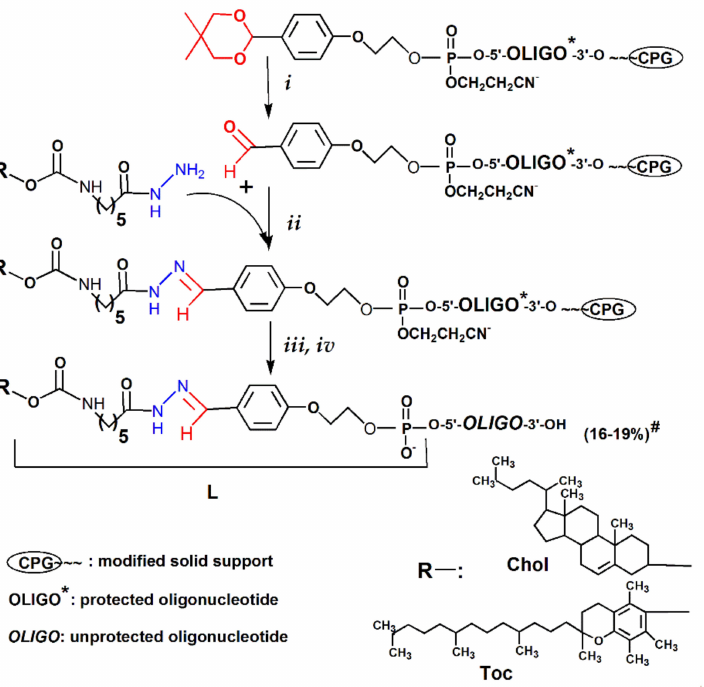
Figure 3. General scheme of the synthesis of 5 (cid:48) -lipophilic conjugates of oligonucleotides. Reagents: ( i ) 80% acetic acid, 1 h, RT; ( ii ) 0.1 M NaOAc(pH 5.2)/dioxane (1/1), 12 h, RT; ( iii ) 0.05 M K 2 CO 3 in methanol, 16 h, RT; and ( iv ) NMP/TEA • 3HF/TEA (150/100/75), 1.5 h, 65 ◦ C. Sequences of oligonucleotides are shown in Table 1. L: -O-C(O)NH-(CH 2 ) 5 -C(O)NH-N=CH-C 6 H 4 -O-(CH 2 ) 2 -O- P(O)(OH)-; Chol: cholesterol residue; Toc: α -tocopherol residue. (#) The yields of conjugates after deblocking and isolation by denaturing PAGE were calculated relative to the first nucleoside on the polymer